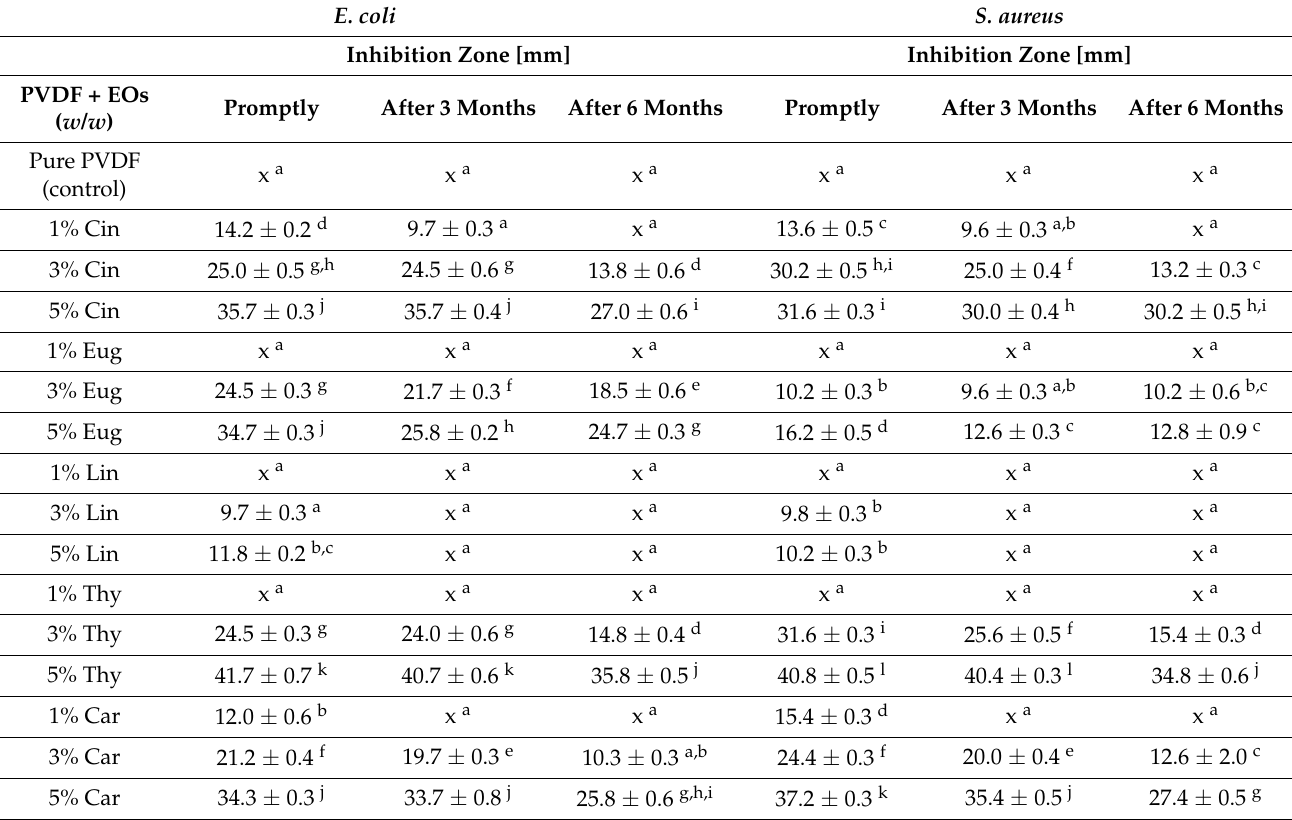
Table 2. Inhibition zone values of PVDF films for bacteria E. coli and S. aureus (disk diameter—9 mm). E.